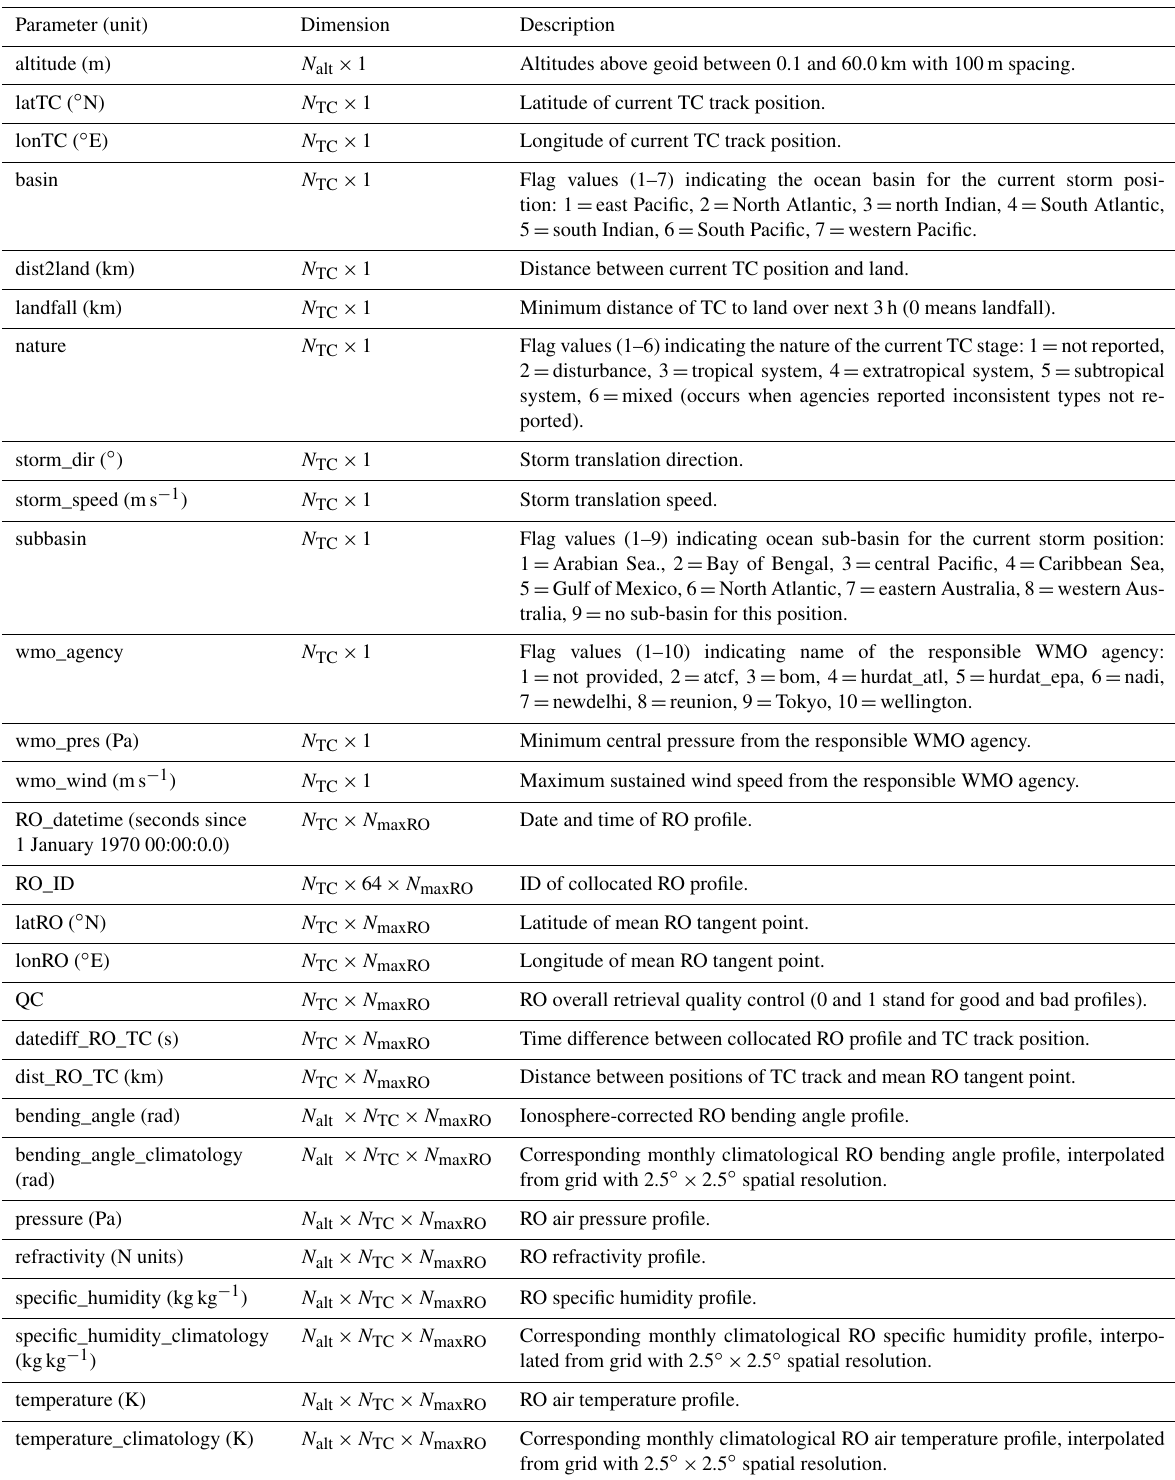
Table 3. Parameters stored in the dataset files for each TC separately. N TC denotes the number of TC track positions, N alt denotes the number of altitude levels (600 by default) and N maxRO stands for the maximum number of RO profiles found for a single TC best track position. Parameter (unit) Dimension